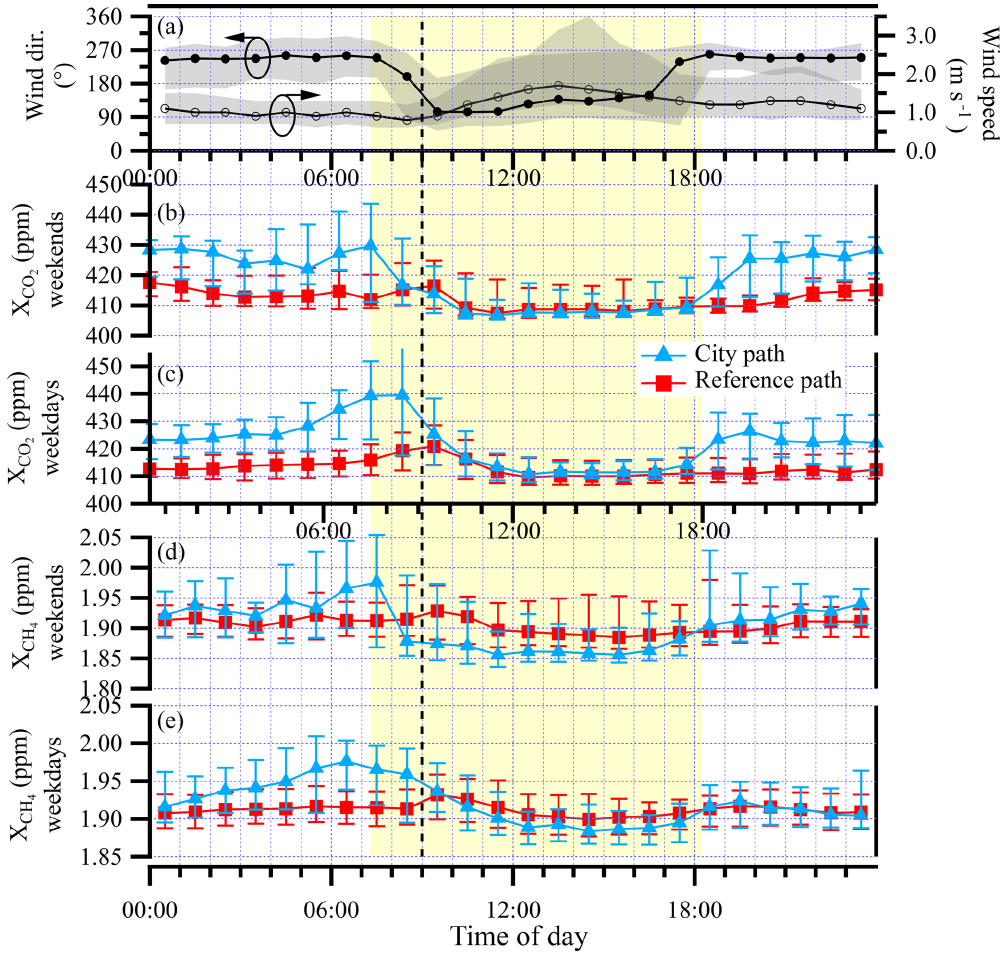
Figure 6. Diurnal cycle analysis. Data are the median of the full 7.5 weeks. (a) The mean direction in which the wind is blowing (black trace, left axis) and the wind speed (gray trace, right axis) are both from the NCAR-Foothills measurement station; shaded regions reflect the 25th to 75th quartiles; (b) the weekend and (c) weekday median X CO squares). Uncertainty bars represent the 25%–75% range of values encountered. Panels (d) and (e) represent the same data for X CH vertical dashed black line marks 09:00 local time and the yellow shaded region highlights the region from sunrise to sunset on 22 October